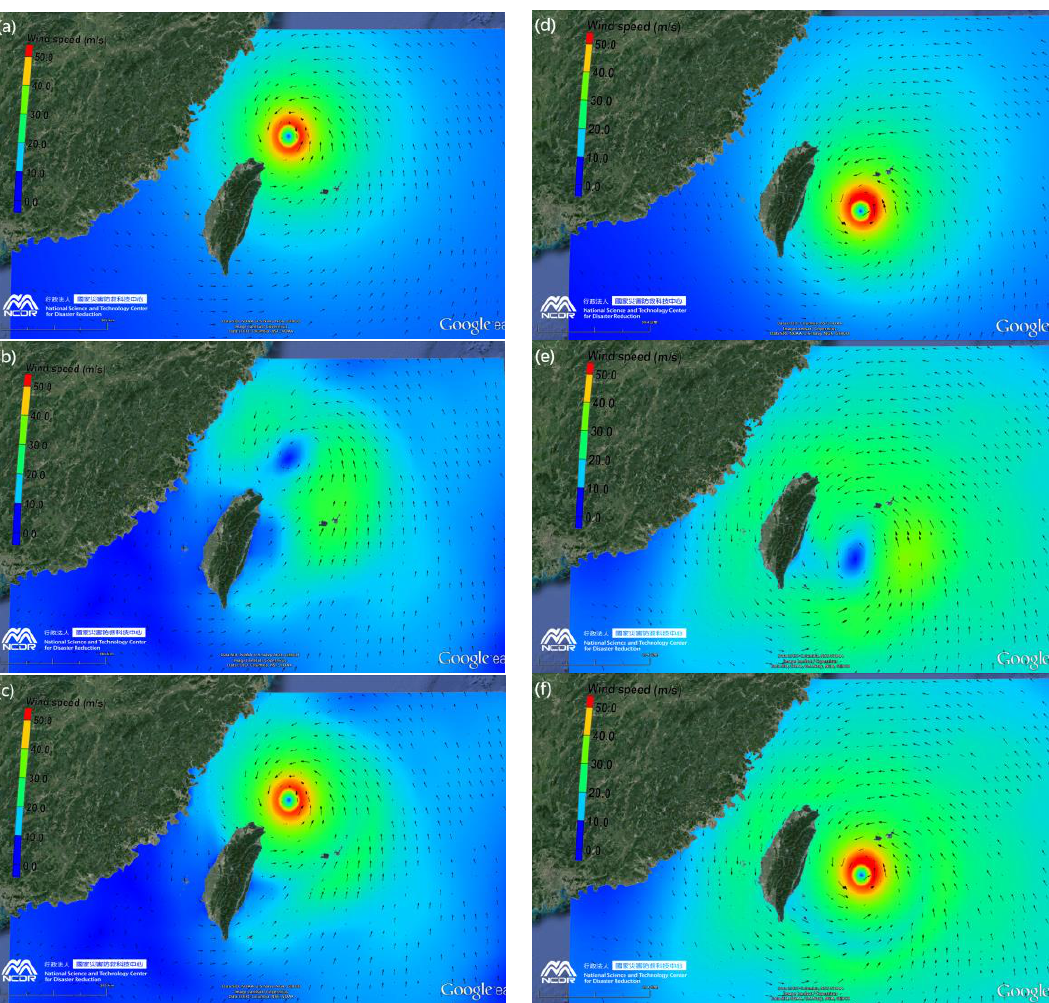
Figure 7. Locations of wave buoys and the track of ( a ) Typhoon Malakas (2016) and ( b ) Typhoon Megi (2016).